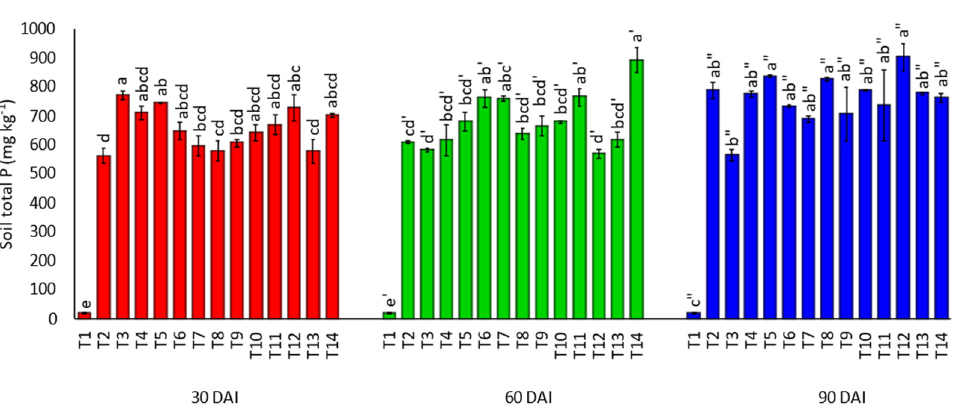
Figure 14. Effects of treatments on soil total phosphorus after thirty, sixty, and ninety days of incubation, where T1: soil alone, T2: Egypt rock phosphate alone, T3: Egypt rock phosphate + 100% charcoal, T4: Egypt rock phosphate + 100% sago bark ash, and T5: Egypt rock phosphate + 100% charcoal + 100% sago bark ash, T6: Egypt rock phosphate + 75% charcoal + 75% sago bark ash, T7: Egypt rock phosphate + 50% charcoal + 75% sago bark ash, T8: Egypt rock phosphate + 25% charcoal + 75% sago bark ash, T9: Egypt rock phosphate + 75% charcoal + 50% sago bark ash, T10: Egypt rock phosphate + 50% charcoal + 50% sago bark ash, T11: Egypt rock phosphate + 25% charcoal + 50% sago bark ash, T12: Egypt rock phosphate + 75% charcoal + 25% sago bark ash, T13: Egypt rock phosphate + 50% charcoal + 25% sago bark ash, and T14: Egypt rock phosphate + 25% charcoal + 25% sago bark ash. Means with different letter(s) within the same incubation period indicate significant differences between treatments according to Tukey’s HSD test at p ≤ 0.05, i.e., a > b > c. Bars represent the mean values ± SE.